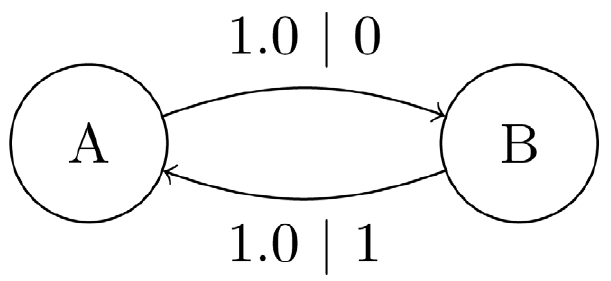
Figure 2. -Machine for the Alternating Process consisting of two causal states S ~ f A , B g and two transitions. State A emits allele 0 with probability one and transitions to state B , while B emits allele 1 with probability one and transitions to A .